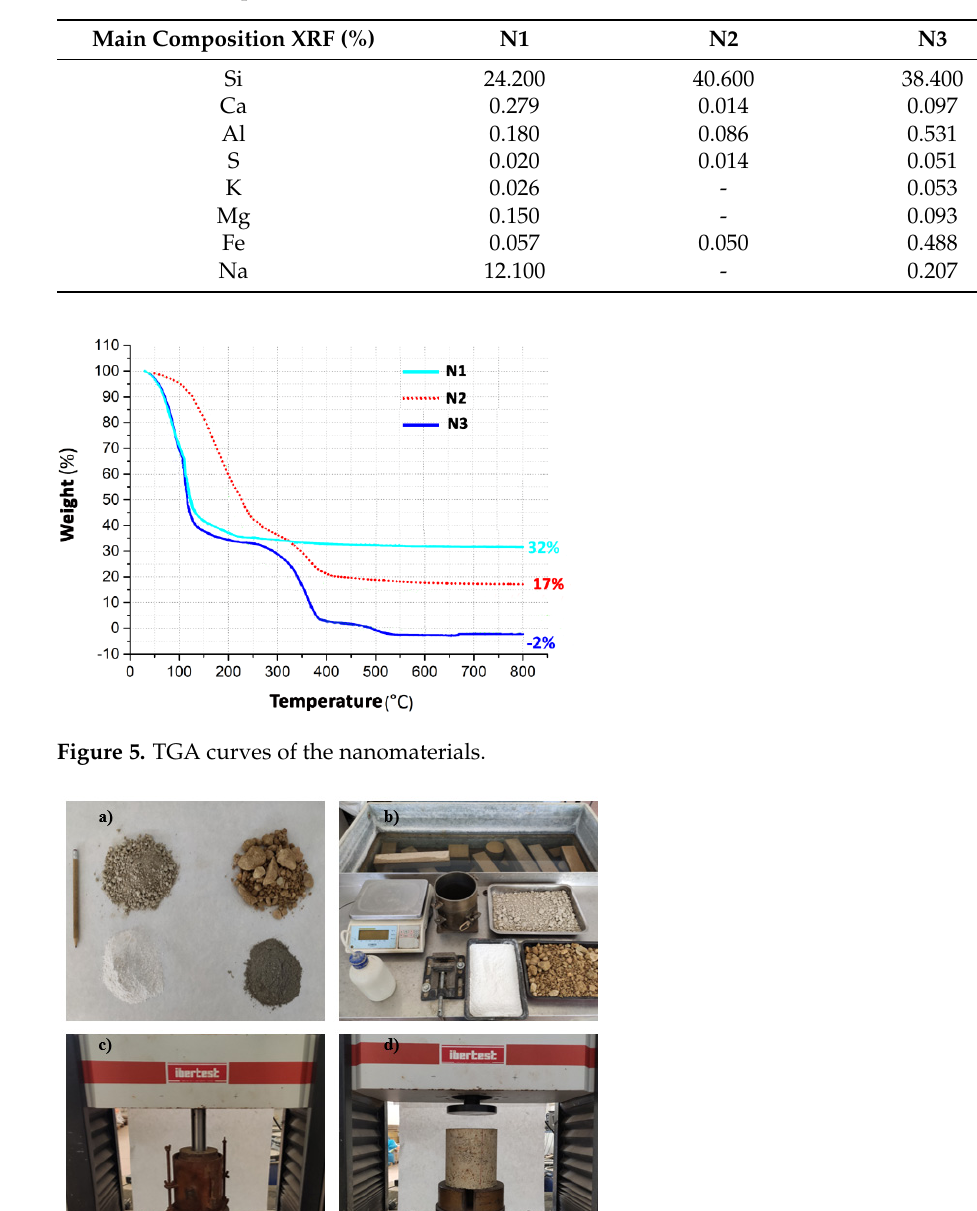
Table 4. Dosages of the mixtures. Designation